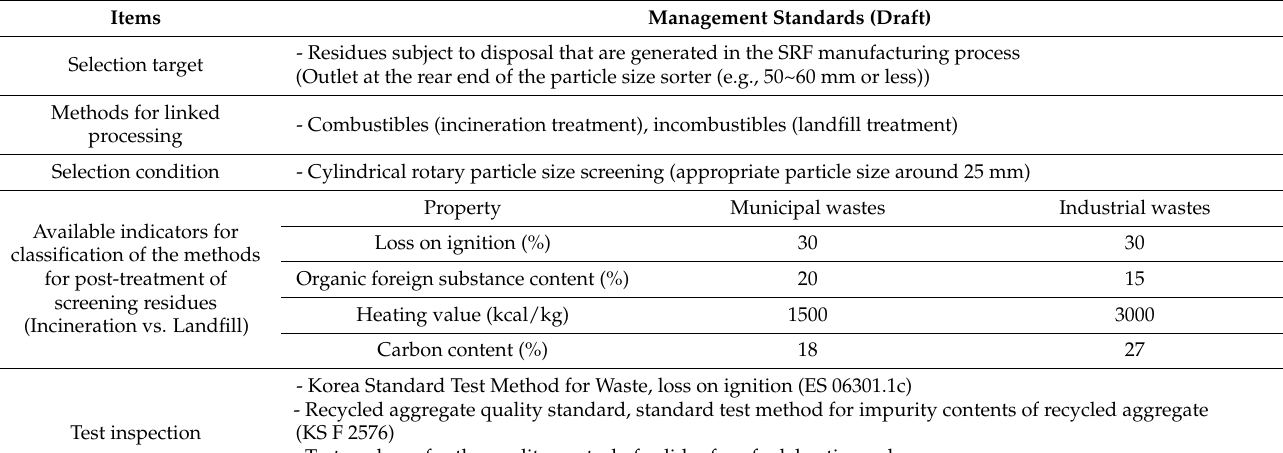
Table 3. Considerations and improvements on the management of residues from SRF